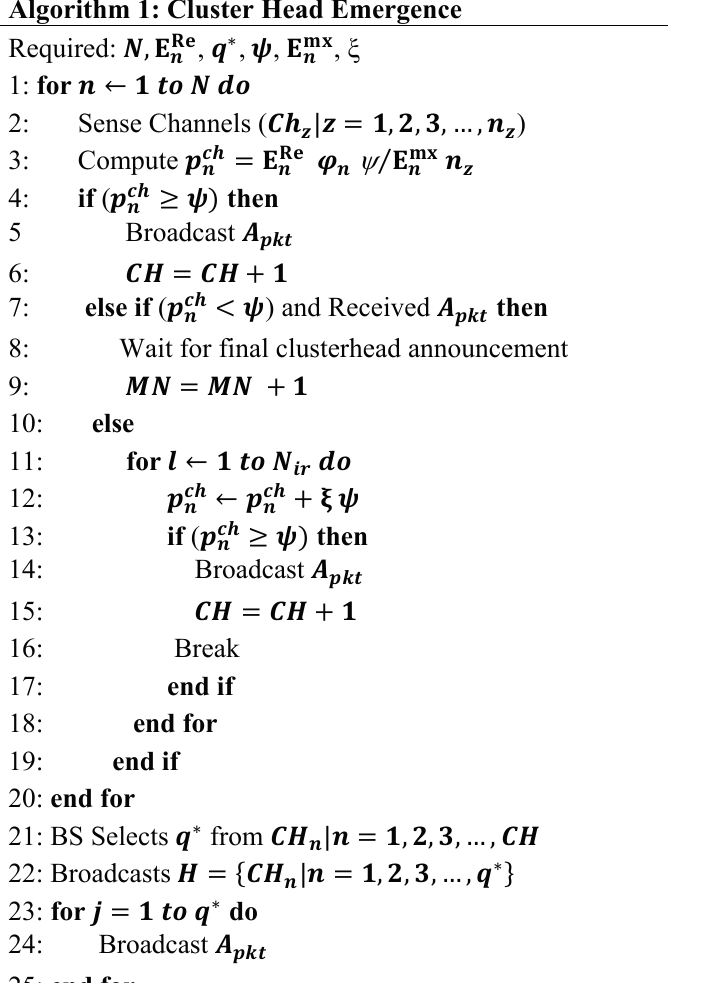
Table 1. Initialization phase. Algorithm 1: Cluster Head